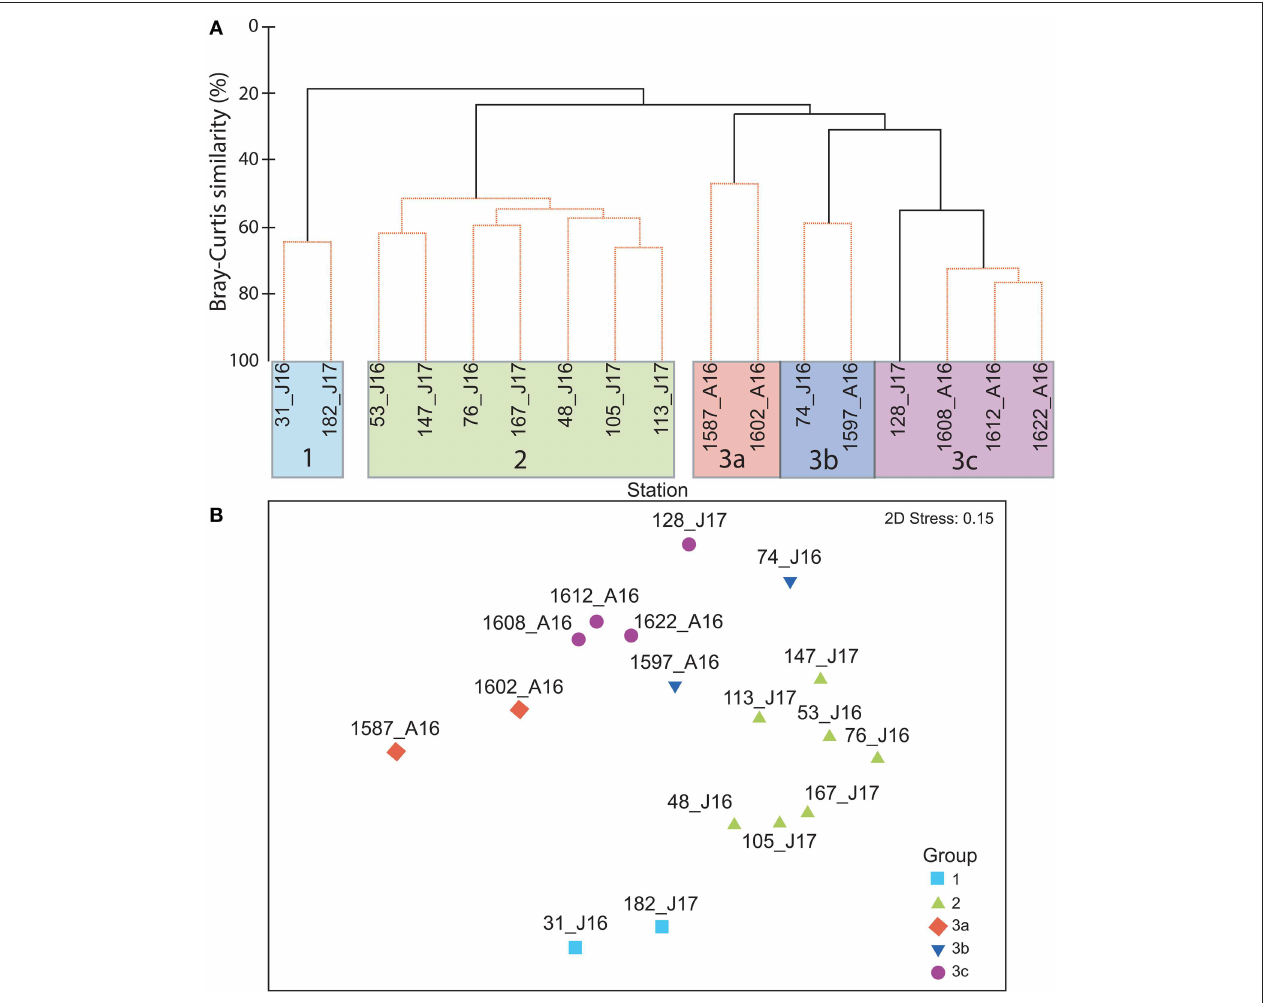
FIGURE 4 | (A) Grouping of stations based on the relative biomass of fish and zooplankton taxa in midwater trawls. (B) Non-metric multidimensional scaling ordination plot illustrating similarities among stations in terms of catch composition. The 3 main groups of stations identified by the cluster analysis are shown. Each station is identified by its number, the month (A = August and J = January), and year (16 = 2016 and 17 = 2017).